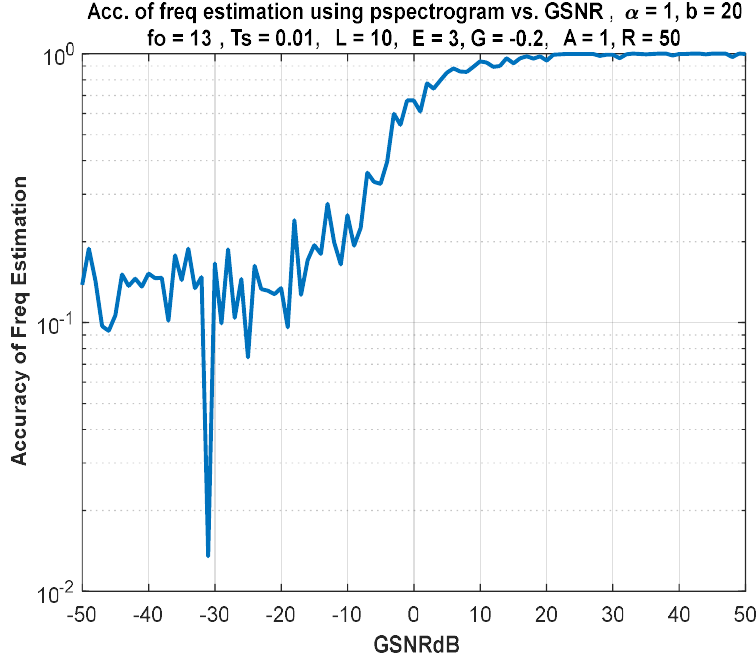
Figure 30. Accuracy of FE for noisy LFM by TFD (pspectrum).